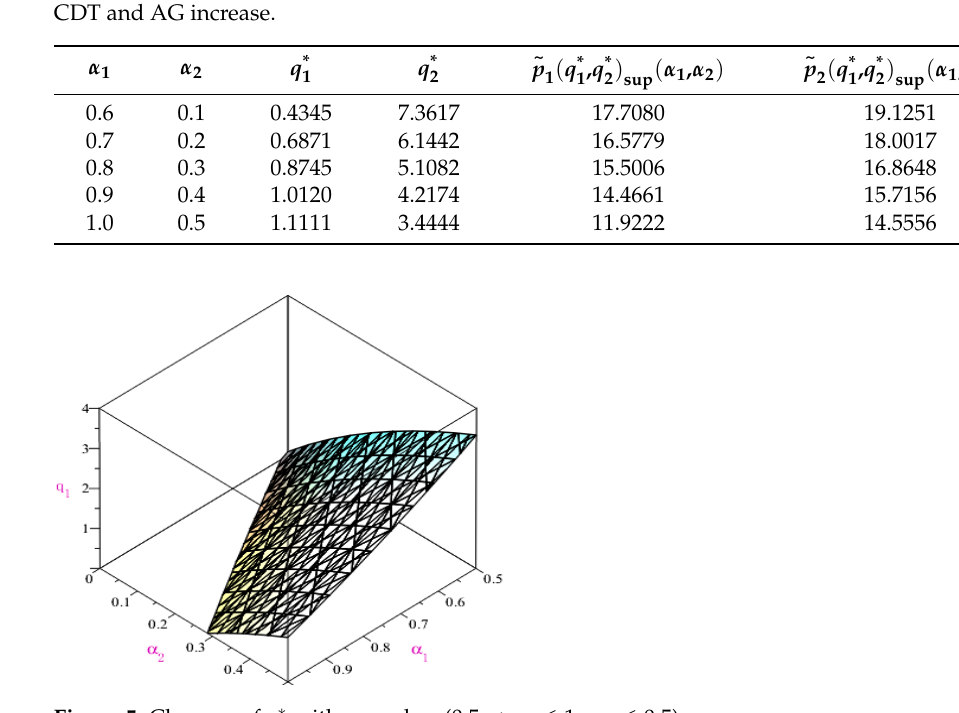
with α 1 and α 2 (0.5 < α 1 ≤ 1, α 2 ≤ 1